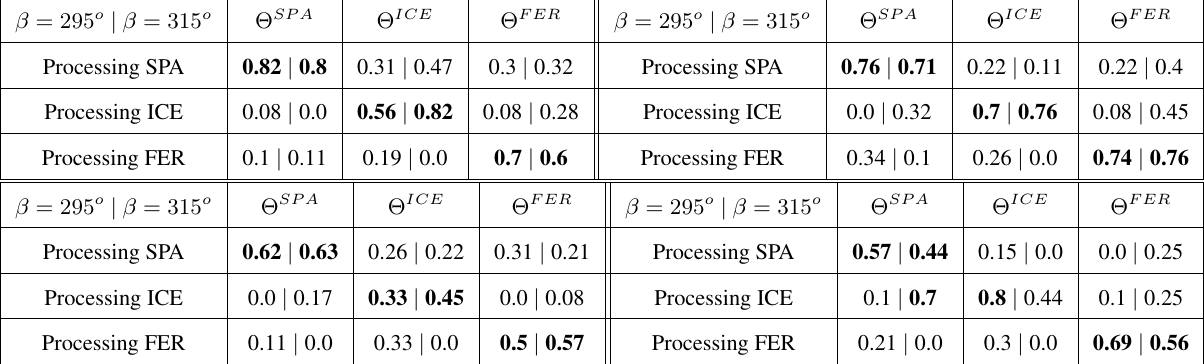
Table 4. Similarity values 0 < S < 1 retrieved for X band simulations in scenarios 0 (up-left), 1 (up-right), 2(down-left) and 3 (down-right) with the quad-pol mode. Bold numbers indicate the model classifying the processed geometry, so if arranged along the matrix diagonal, VCA performs